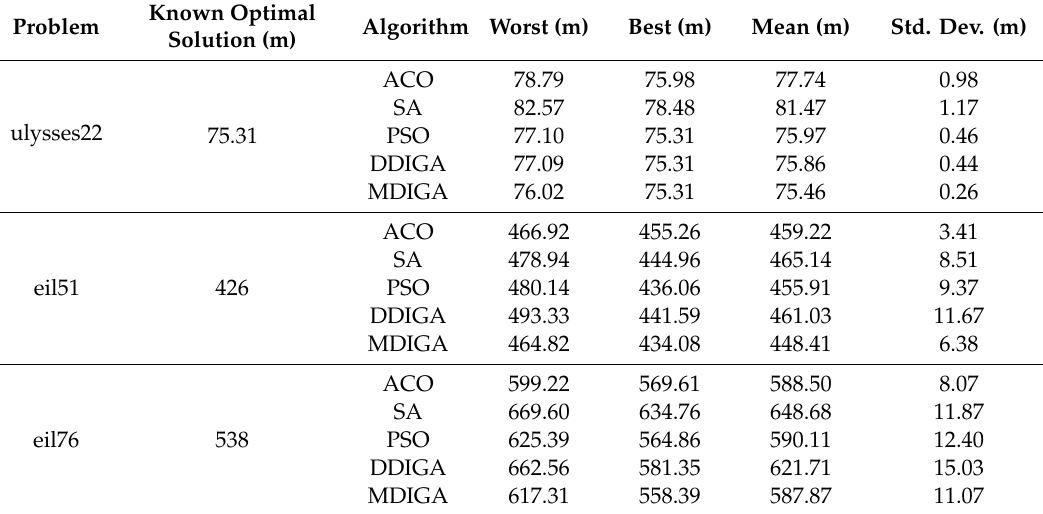
Table 3. Comparative results with other state-of-the-art approaches for three problems.